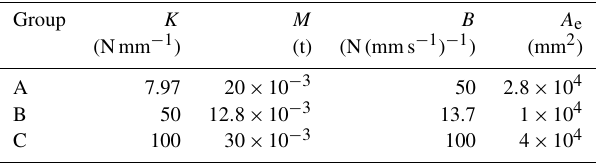
Table 2. Parameter of a rubber bellows type pressure compensator.